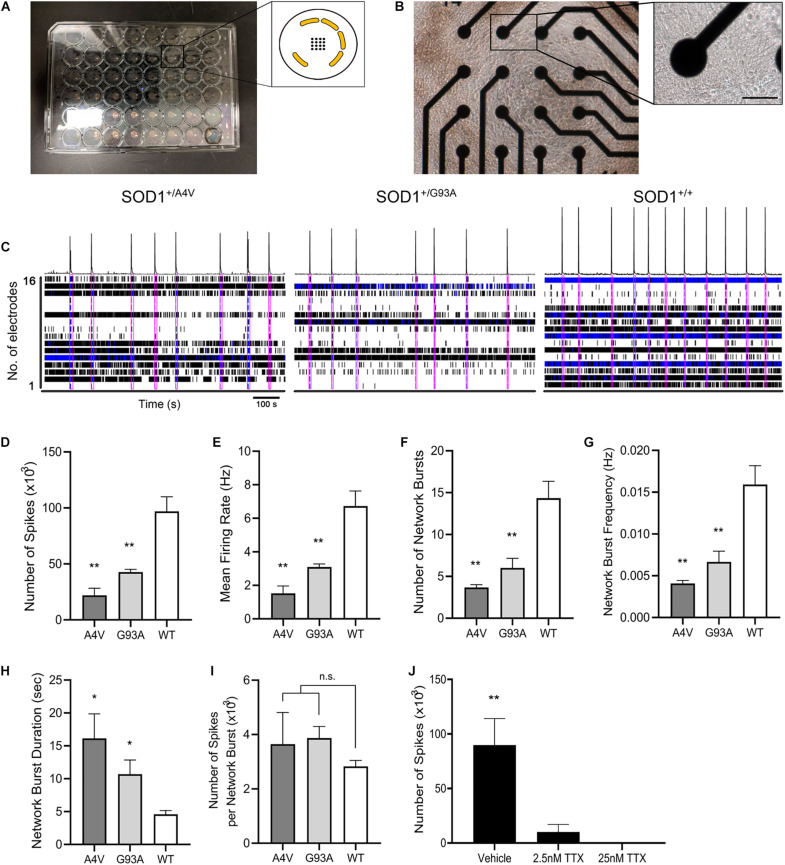
Functional networks are defective in SOD1+/A4V and SOD1+/G93A MN cultures. (A) Microelectrode array plate with 16 electrodes in the center of each well. Electrodes (black) are arranged in a 4 × 4 grid with peripheral grounds (yellow). (B) Phase-contrast image of iPSC-derived MNs cultured on the plate in each well. Scale bar, 50 μm. Enlarged image shows a single electrode in contact with MNs in culture. (C) Spontaneous firing of action potentials shown as raster plots and spike histogram during 900 s episodes. Pink boxes indicates network bursts. (D) Total number of spikes, (E) mean action potential firing rates (Hz), (F) total number of network bursts, (G) network burst frequency (Hz), (H) average network burst duration (s), and (I) average number of spikes in a network burst during 900 s episodes. (J) Effects of TTX treatment on neuronal activity. MEAs were done on MNs at 72 DIV for (A–I) and 226 DIV for (J). n = 3 biological replicates. All data shown as mean ± SEM. *p < 0.05, **p < 0.01.